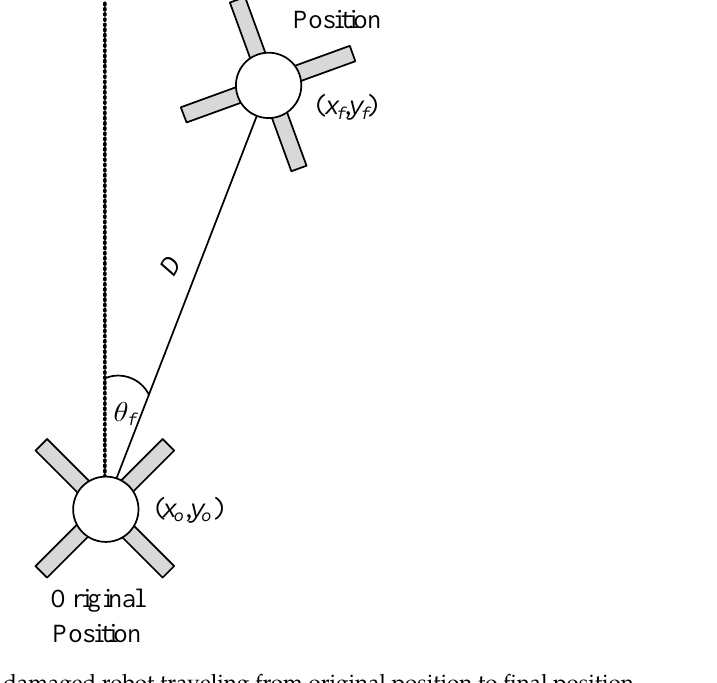
Figure 8. Trajectory of damaged robot traveling from original position to final